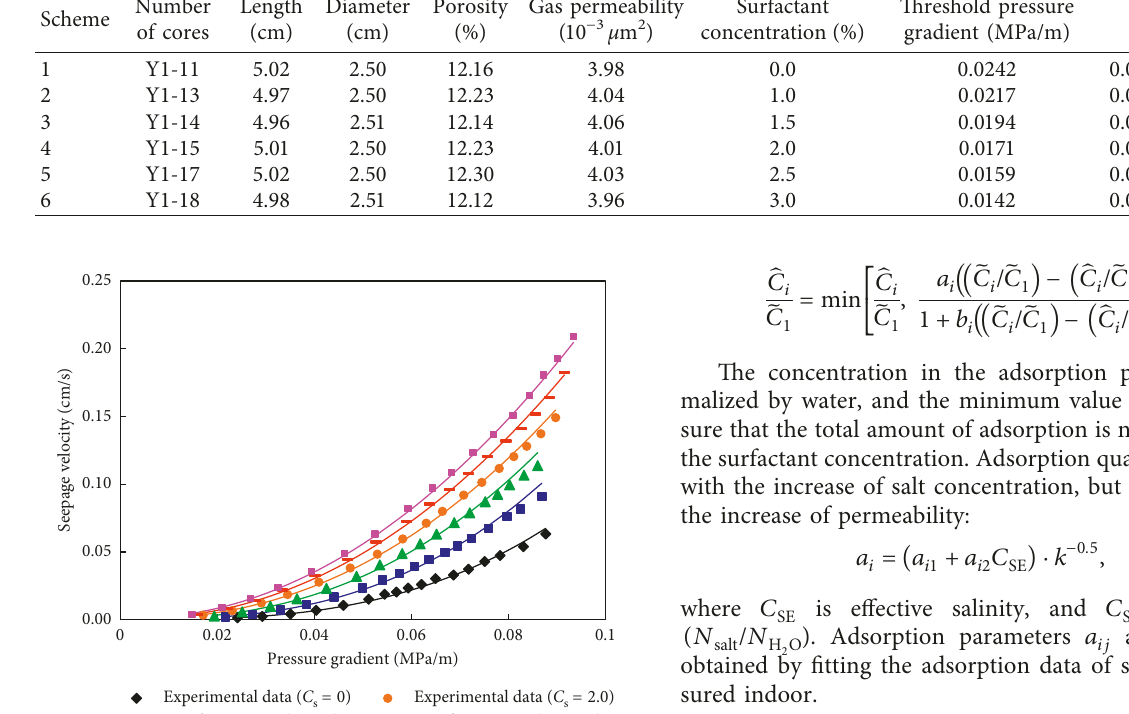
Experimental data ( C s = 2.0) Simulative curve ( C s = 2.0) Experimental data ( C s = 2.5) Simulative curve ( C s = 2.5) Experimental data ( C s = 3.0) Simulative curve ( C s = 3.0)